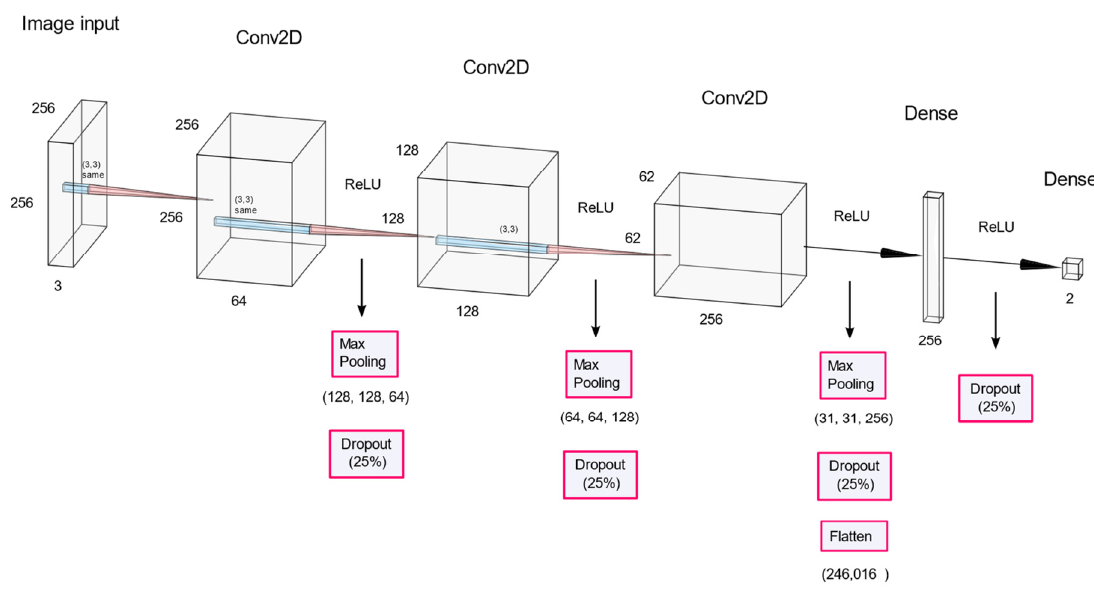
Figure 3. Representation of the CNN structure used in this study, in the AlexNet format. The CNN is a series of convolution operations, and the output calculation of neurons in the convolution layer is the same as in Equation (3). Here, z i , j , k is the output of the neuron located at row i and column j in the k feature map of Conv2D, which is a convolutional layer. Furthermore, s h and s w are the vertical and horizontal strides, respectively; f h and f w are the height and width of the kernel, respectively. A matrix in which a specific number for the convolution operation is combined is called a kernel or filter, and the interval in which the kernel is applied is called a stride. Here, f n (cid:48) is the number of feature maps in the previous convolutional layer, while x i (cid:48) , j (cid:48) , k (cid:48) are the outputs of the neurons in row i (cid:48) , column j (cid:48) , and k (cid:48) feature maps of the previous convolutional layer, respectively. Additionally, b